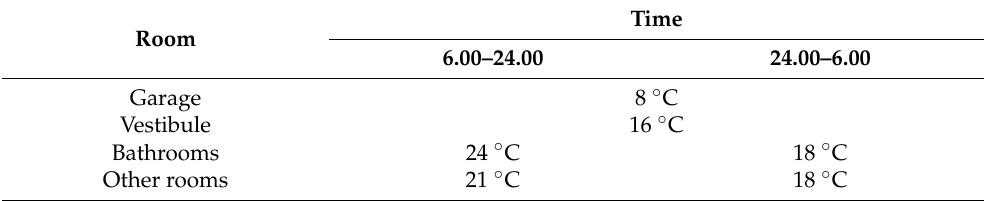
Table 1. Indoor temperature in